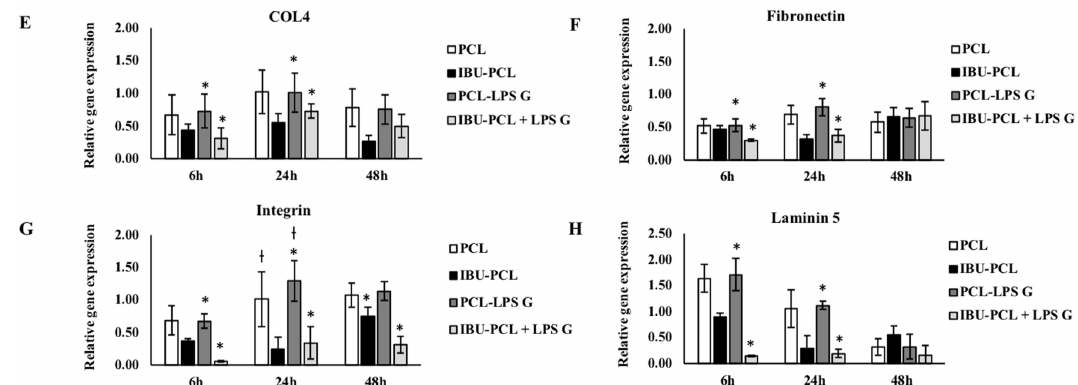
Figure 5. Gene expression of collagen-IV, fibronectin-1, integrin α 3 β 1 and laminin-5 in EC cultured on